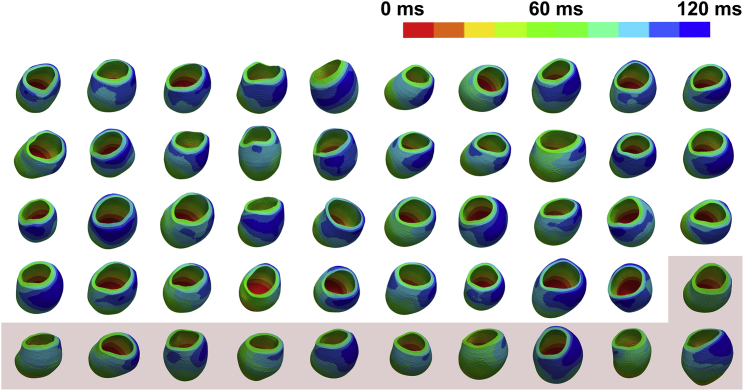
Patient model simulations. Intrinsic activation (non-LBBB approximation) was simulated for the male patient models (n = 39) to achieve a total activation time of 120 ms. The mean male CV was then applied to each of the female patient models (red, n = 11) to determine the equivalent female total activation times. To see this figure in color, go online.